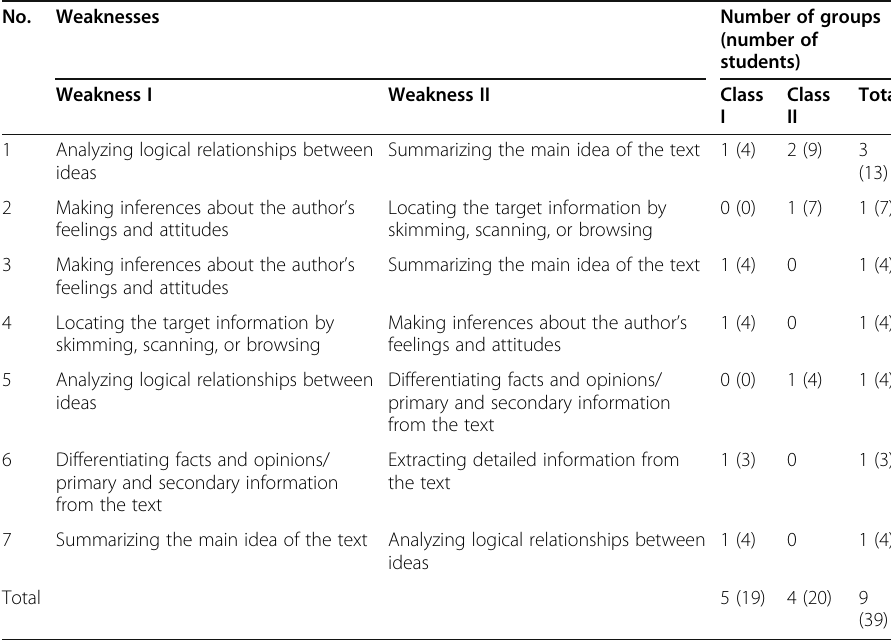
Table 4 Group divisions of the two classes in the experimental group No.